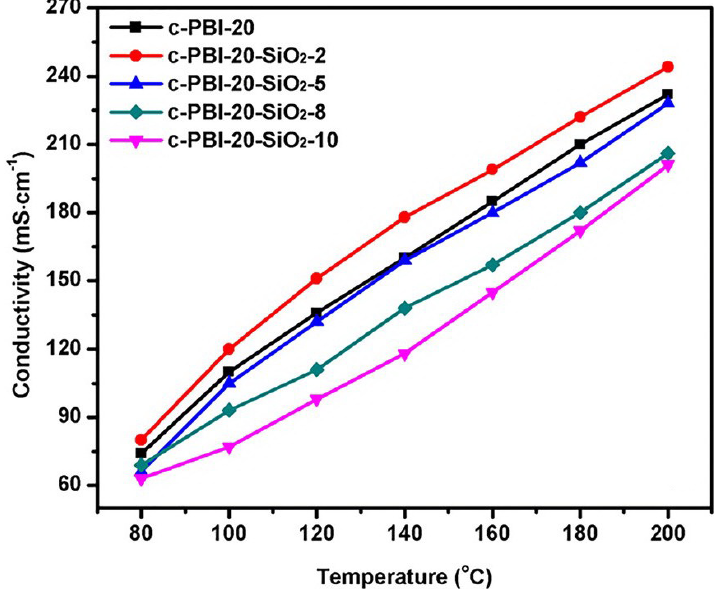
Figure 11. The proton conductivity of the SiO 2 /c-PBI-20 composite membranes (taken from Ref.